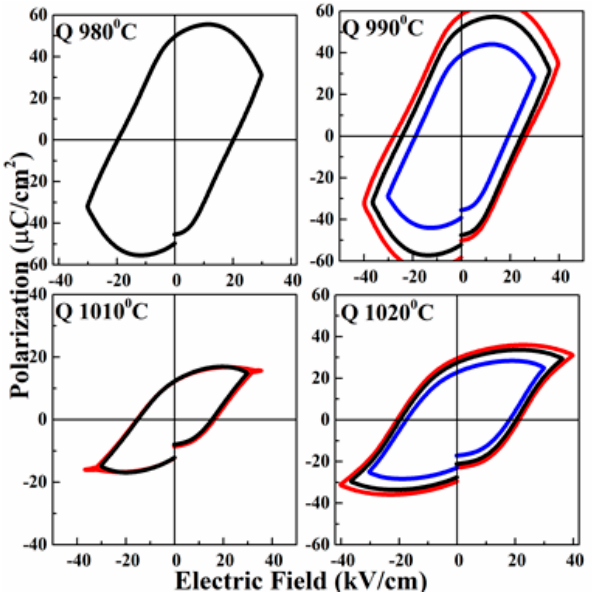
Figure 5. Ferroelectric properties of BFBT–zBCZT (z = 0.00) sample sintered at 980 °C, 990 °C, 1010 °C and 1020 °C.